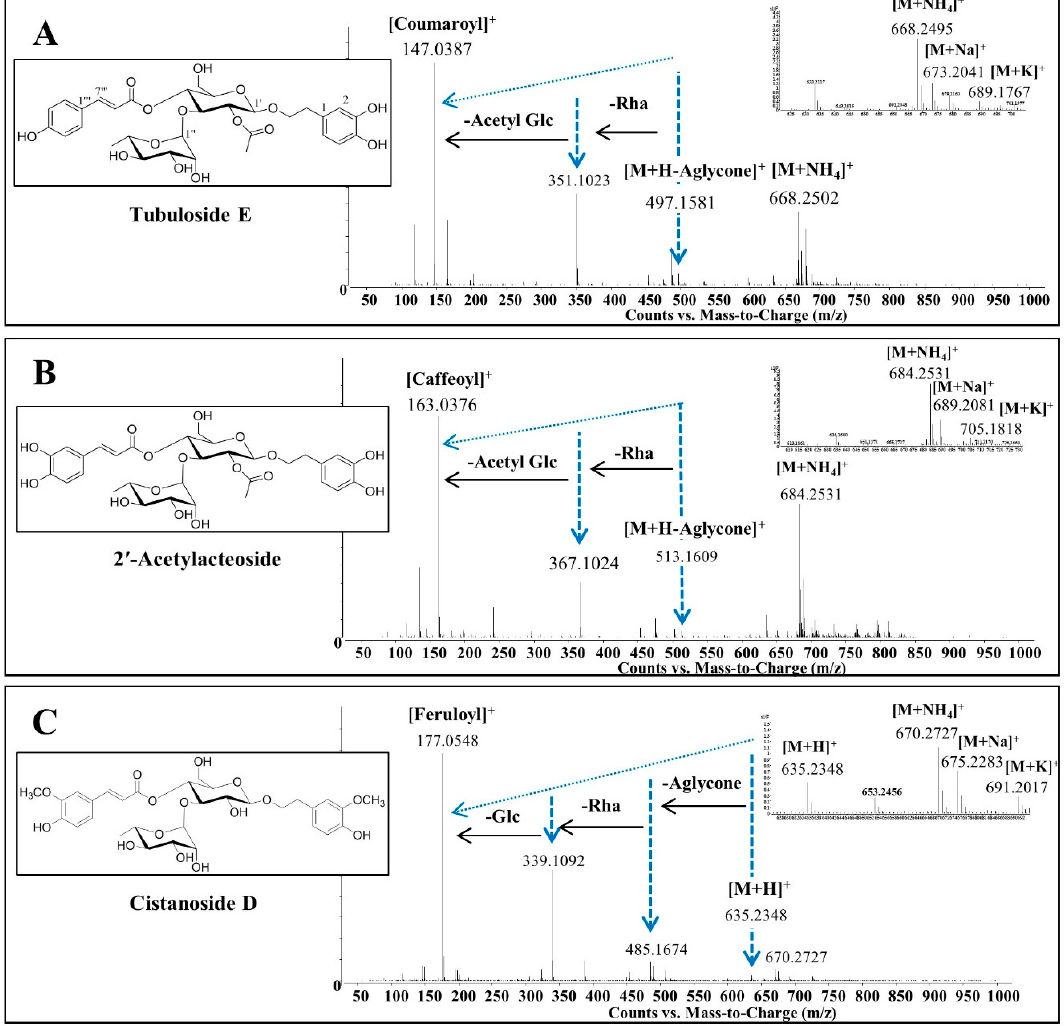
Figure 2. The fragmentation pathways of phenylpropanoid-substituted diglycosides. ( A ) Tubuloside E, C 31 H 38 O 15 , M.W. 650; ( B ) 2’-Acetylacteoside, C 31 H 38 O 16 , M.W. 666; ( C ) Cistanoside D, C 31 H 40 O 15 , M.W. 652